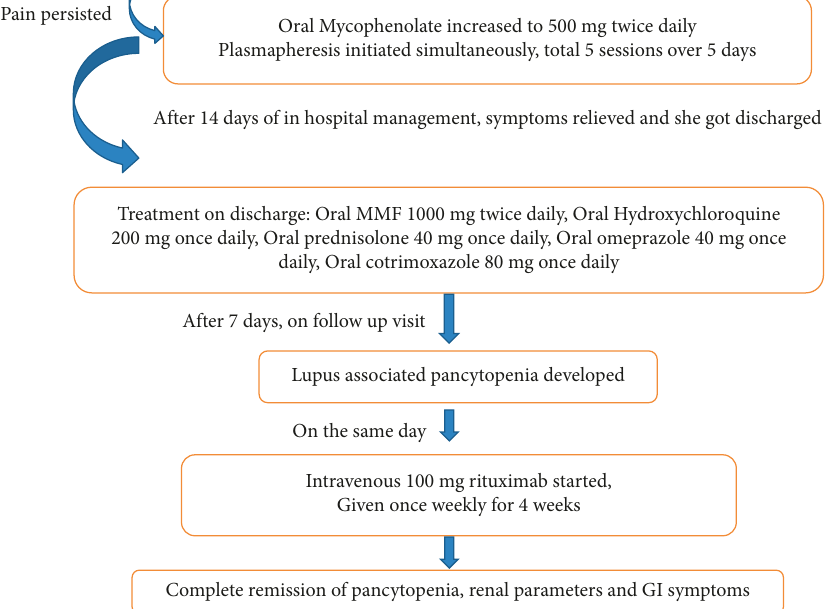
Figure 6: Summary of treatment received by the